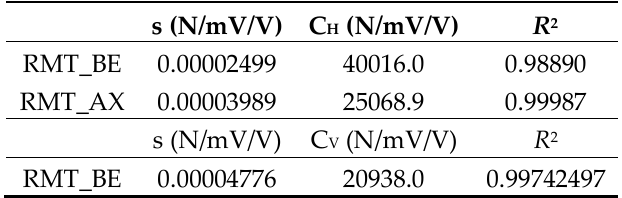
Table 2. Results of bridge calibration with horizontal and vertical loads.